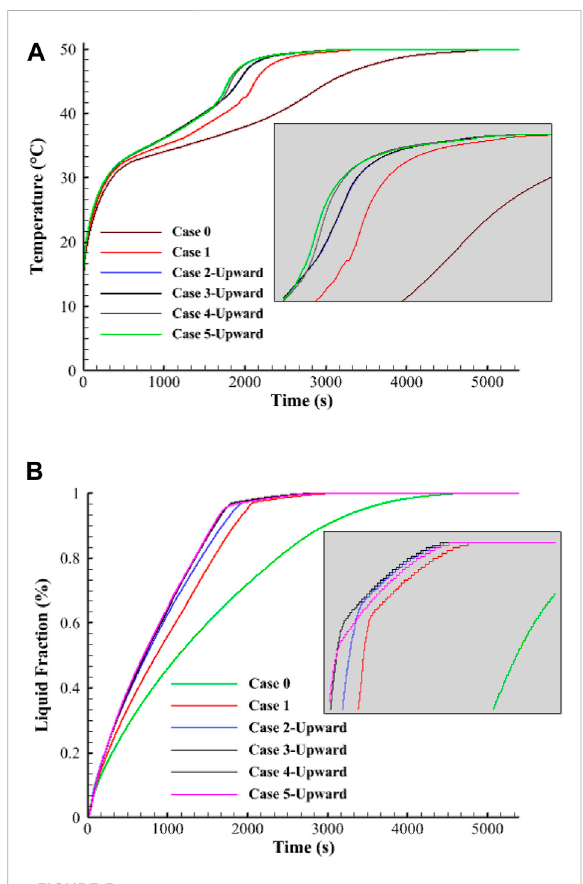
FIGURE 5 Variationof (A) temperatureand (B) liquidfractionofthePCM for different studied cases during the melting